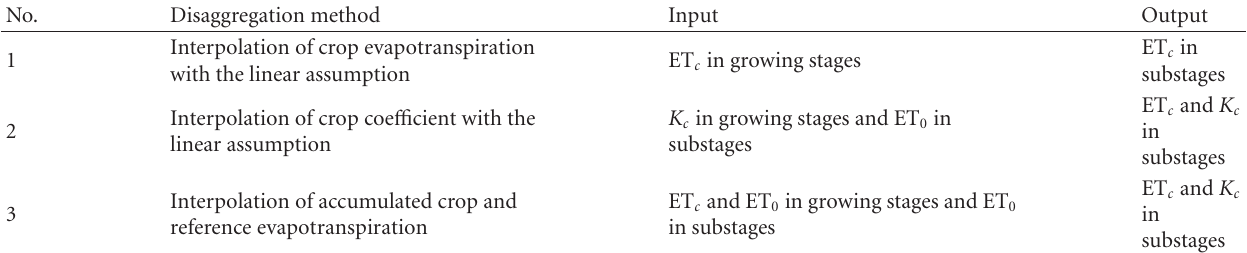
Table 2: Disaggregation methods for crop coe ffi cient ( K c ) and crop evapotranspiration (ET c